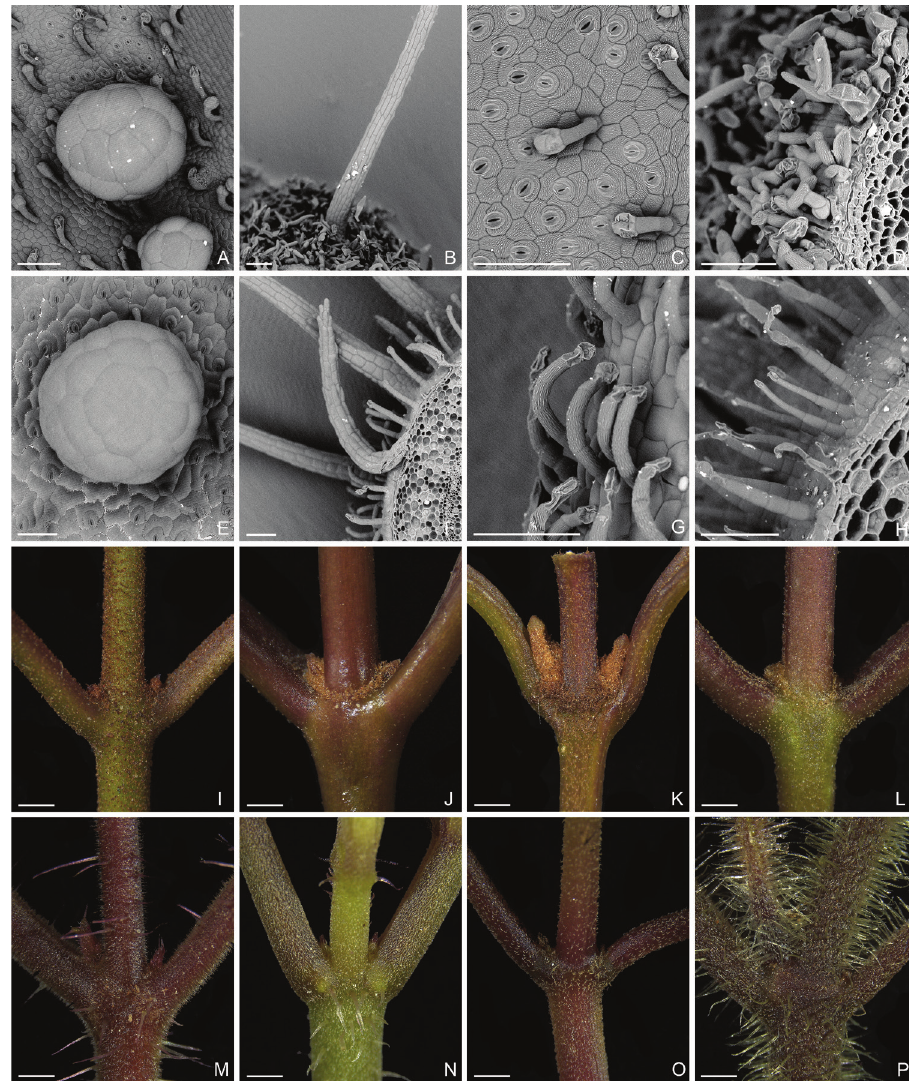
Figure 5. Trichomes in the Tashiroea clade and the Bredia clade. A–D Micrographs of trichomes in the Tashiroea clade: A sessile gland with thin-walled head in T. nudipes ( Y. Liu 435 ) B multiseriate trichomes in T. amoena ( Y. Liu 571 ) C appressed uniseriate trichomes with glandular heads in T. nudipes ( Y. Liu 435 ) D yellowish uniseriate trichomes (branched or unbranched) in T. quadrangularis ( Y. Liu 585 ). E–H Mi- crographs of trichomes in the Bredia clade: E sessile gland with thin-walled head in B. longiradiosa var. pulchella ( Y. Liu 485 ) F multiseriate trichomes in B. repens ( Y. Liu 558 ) G appressed uniseriate trichomes with glandular heads in B. gibba ( Y. Liu 566 ) H spreading uniseriate trichomes in B. hirsuta ( Y. Liu 563 ). I–L Stereoscopic images of the Tashiroea clade, showing buds covered in yellowish uniseriate trichomes I T. amoena ( Y. Liu 571 ) J T. nudipes ( Y. Liu 435 ) K T. quadrangularis ( Y. Liu 585 ) L T. yaeyamensis ( Y. Liu 631 ). M–P Stereoscopic images of the Bredia clade, showing buds without yellowish uniseriate trichomes: M B. dulanica ( Y. Liu 565 ) N B. gibba ( Y. Liu 566 ) O B. gracilis ( Y. Liu 457 ) P B. yunnanensis ( Y. Liu 627 ). Scale bars: 100 μm ( A–H ); 1 mm ( I–P